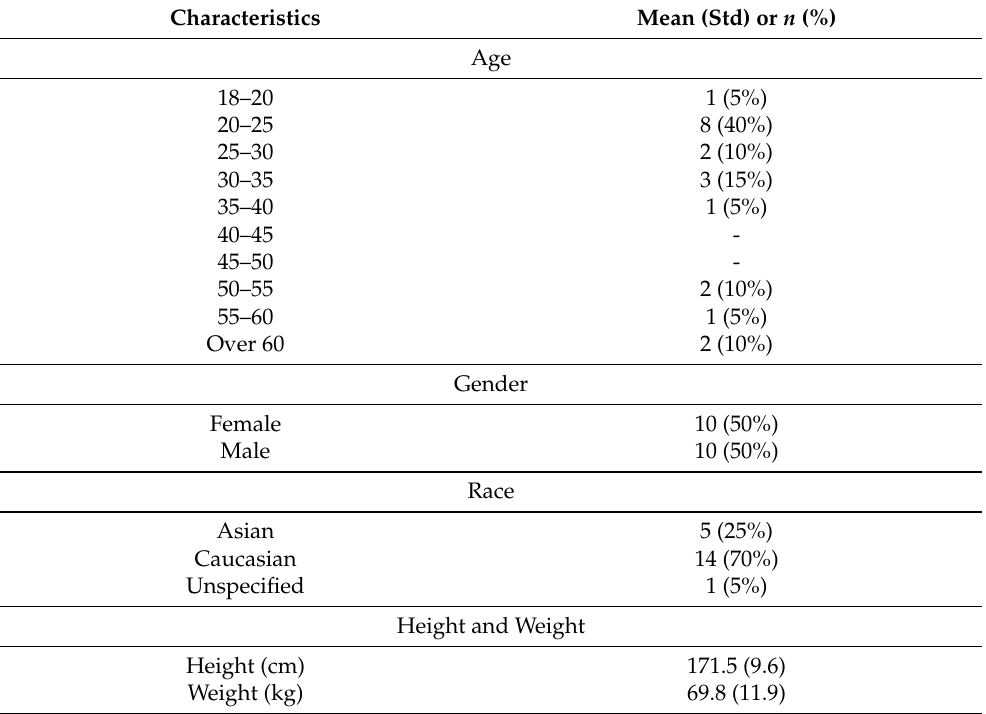
Table 2. Highlights of the subjects’